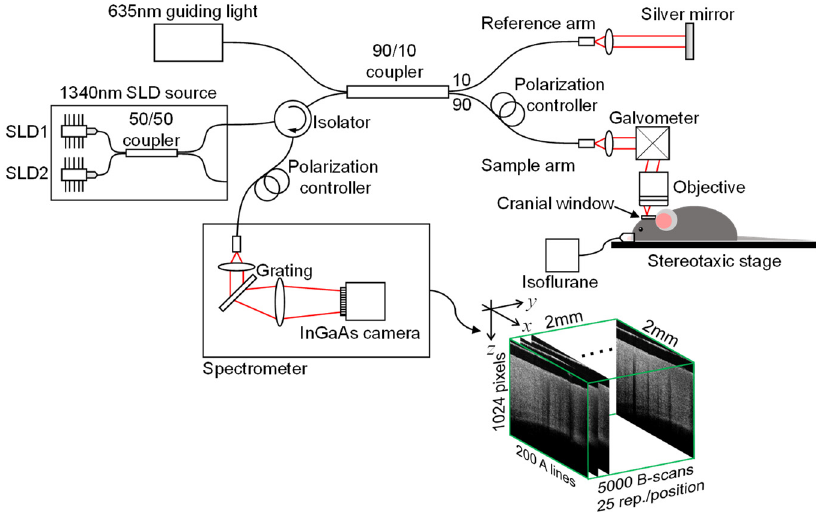
Figure 2. Schematic of the spectral domain OCT setup.